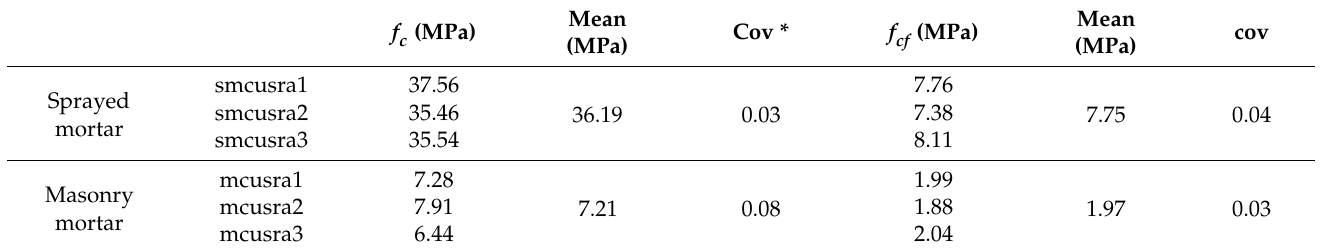
Table 6. Summary of strength test results for sprayed mortar and poured